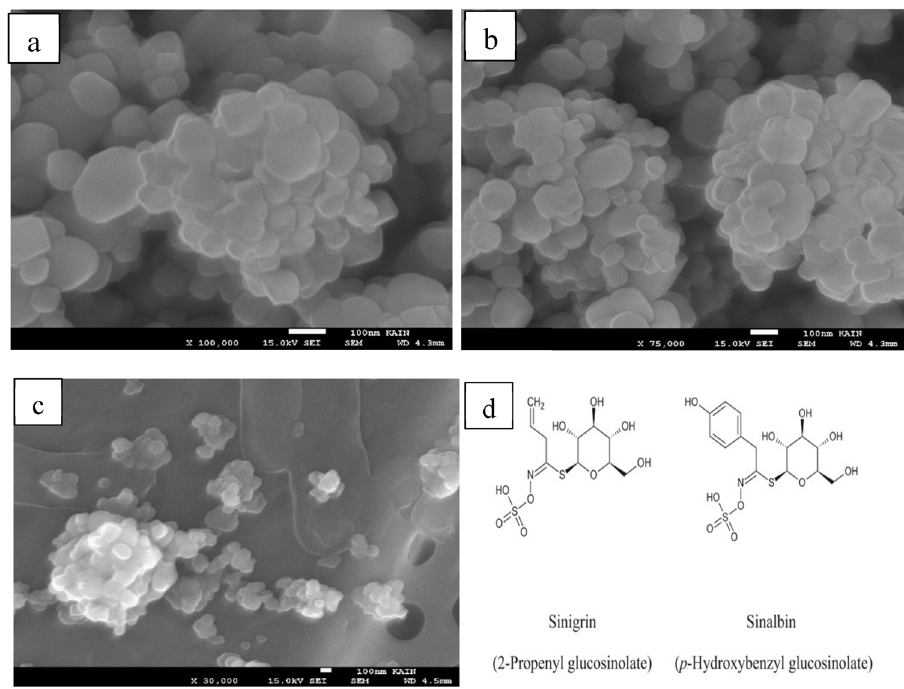
Figure 3: ( a – c ) Micrographs obtained by scanning electron microscopy, showing morphology and size of the mustard seed nanoparticles. ( d ) Chemical structure of mustard seed glucosinolates, sinalbin, and sinigrin.